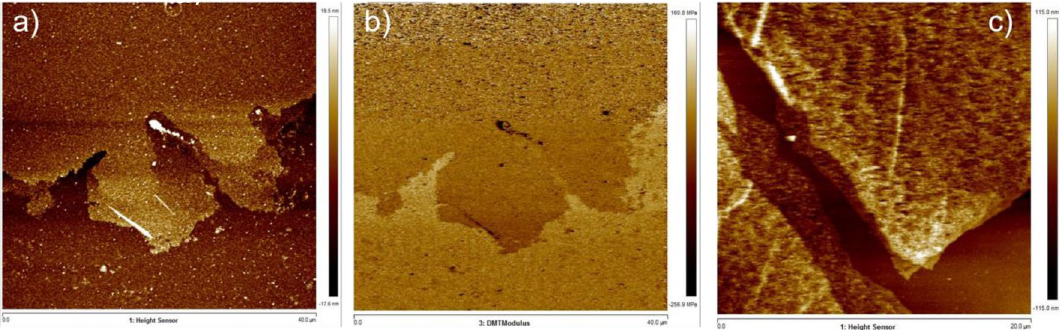
Figure 7. AFM images of the 3D structures created using n-hexane. ( a ) height image and ( b ) DMT module mapping ( c ) AFM images of the 3D structures created using n-hexane solvent after evaporation of encapsulated hexane.